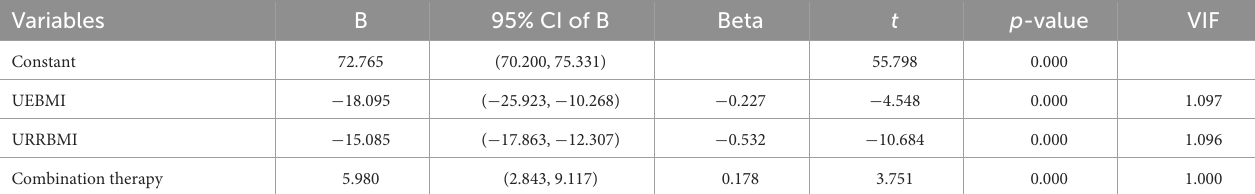
TABLE 5 The association between sociodemographic variables, clinical data, and ITP behaviors.